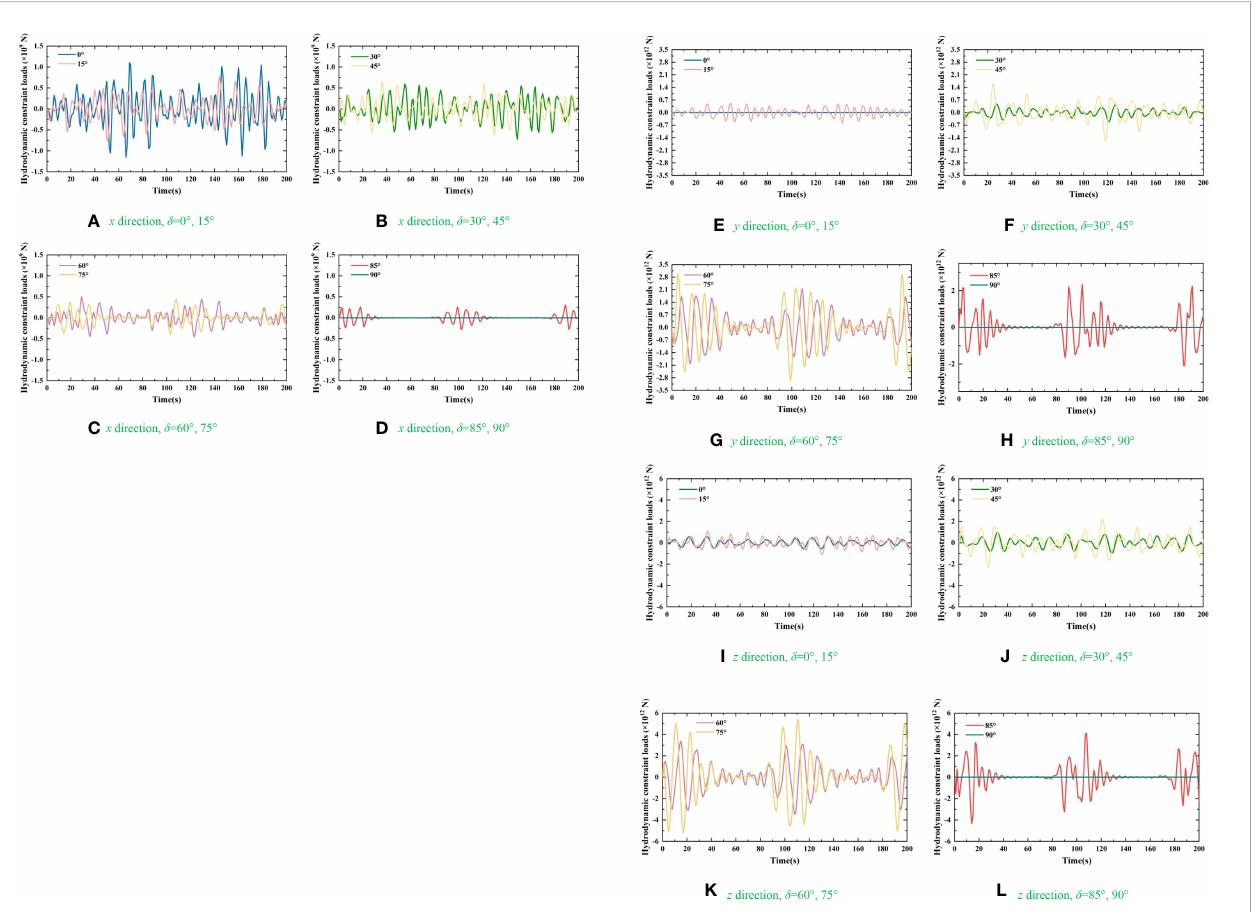
FIGURE 14 Time-domain hydrodynamic constraint loads of C 1 : (A) x direction, d =0°, 15°; (B) x direction, d =30°, 45°; (C) x direction, d =60°, 75°; (D) x direction, d =85°, 90°; (E) y direction, d =0°, 15°; (F) y direction, d =30°, 45°; (G) y direction, d =60°, 75°; (H) y direction, d =85°, 90°; (I) z direction, d =0°, 15°; (J) z direction, d =30°, 45°; (K) z direction, d =60°, 75°; (L) z direction, d =85°,